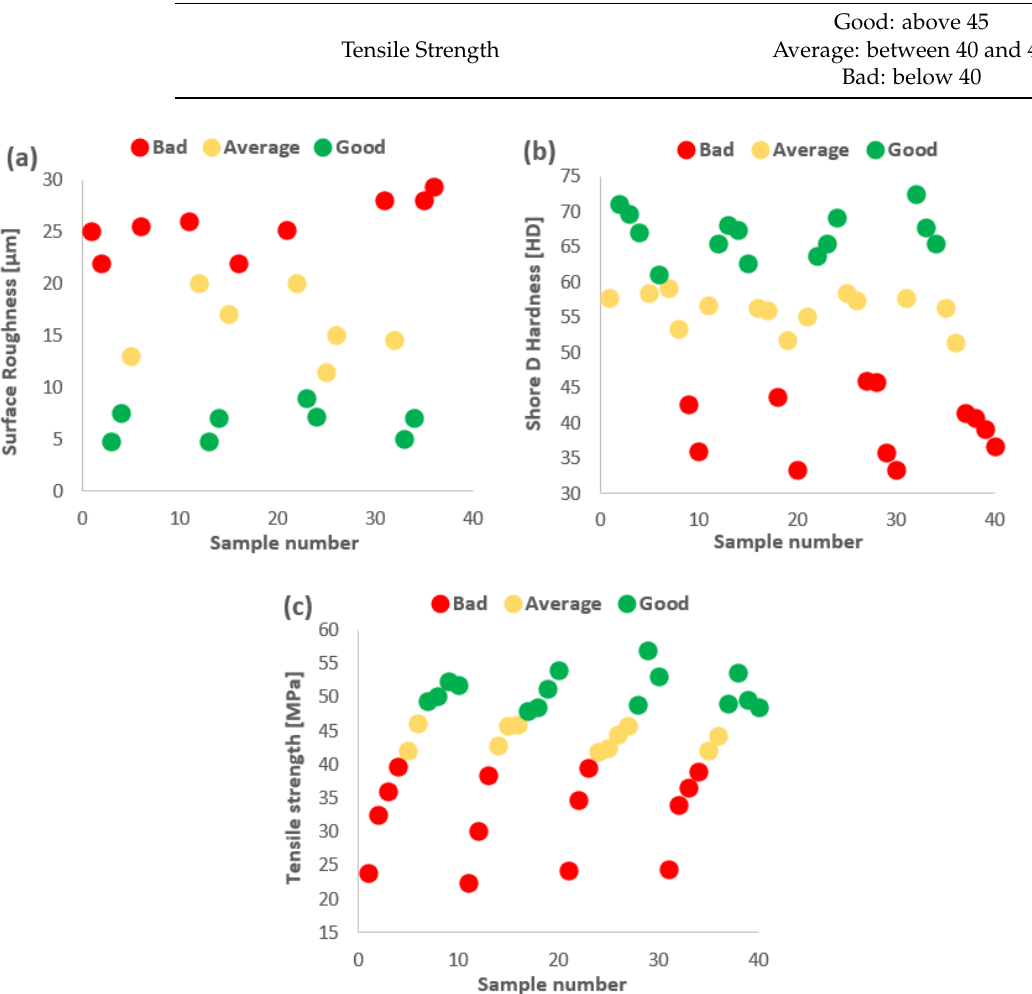
Figure 16. Categorisation results: ( a ) Surface roughness; ( b ) Shore D hardness; ( c ) Tensile